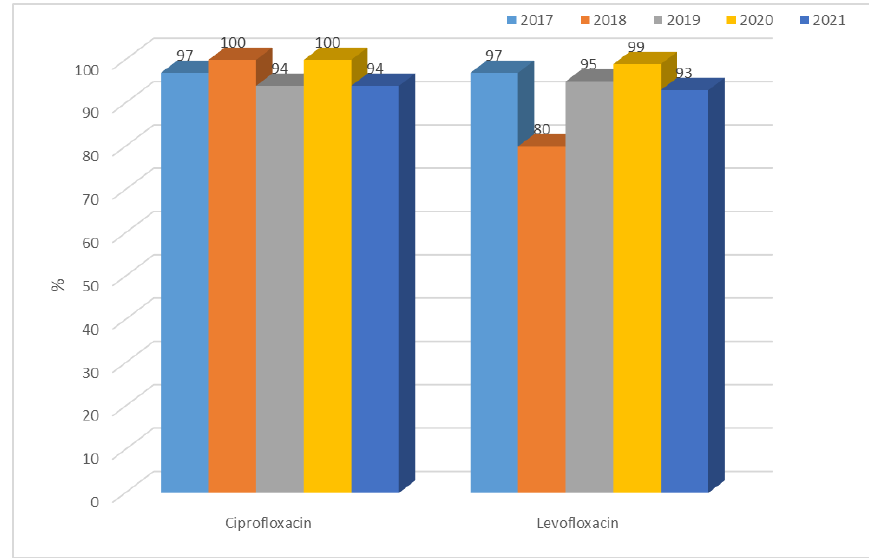
Figure 22. Percentage of K. pneumoniae ESBL(+) strains resistant to quinolones.